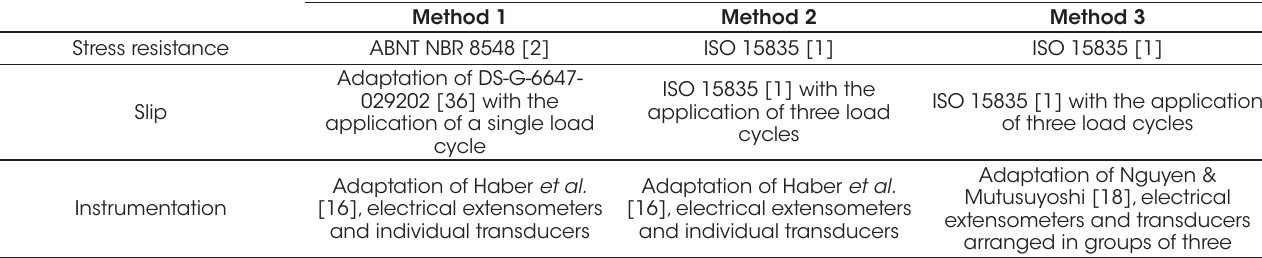
Table 3 Test procedures applied to mechanically spliced